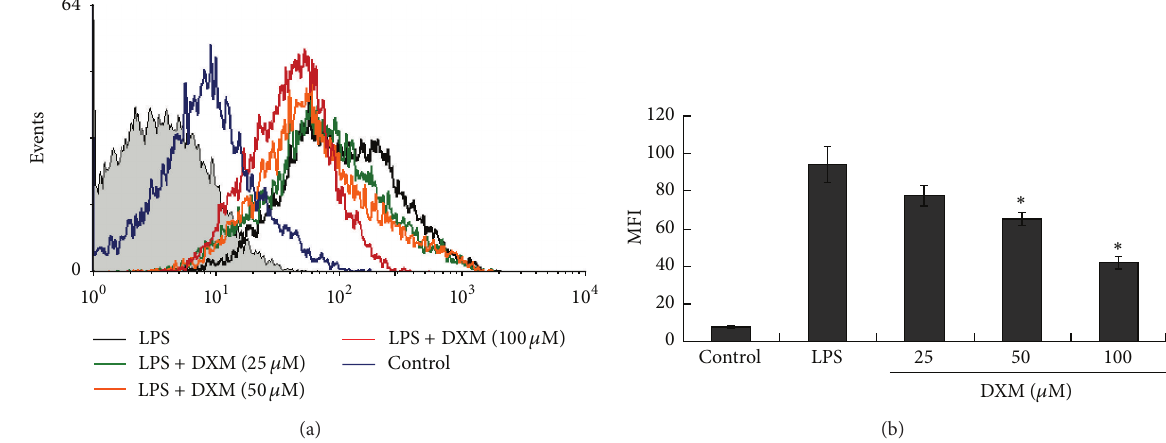
Figure 3: ROS production in LPS-stimulated BMDCs was impaired by DXM. Immature BMDCs were stimulated with 100ng/mL LPS with or without DXM for 18h. The control group was treated with PBS alone. After incubation, the cells were harvested, stained with DCFDA, and analyzed by flow cytometry. The mean fluorescence intensities for ROS generation were tabulated. The data are represented as the mean ± SD in triplicate tests. All data are representative of three independent experiments. Significant differences between DXM-treated and untreated LPS-activated BMDCs are shown with asterisks ( ∗ 𝑃 < 0.05